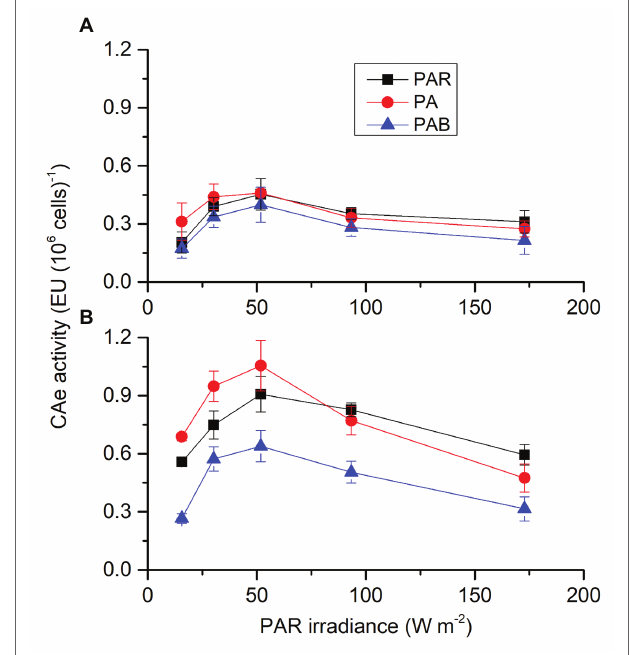
FIGURE 1 | Activity of extracellular carbonic anhydrase (CAe) of Skeletonema costatum cultured at ambient (A) and lower CO 2 (B) levels when exposed to different radiation treatments. PAR, photosynthetically active radiation; PA, PAR + UVA, PAB, PAR + UVA + UVB. The error bars indicate the SDs ( n =